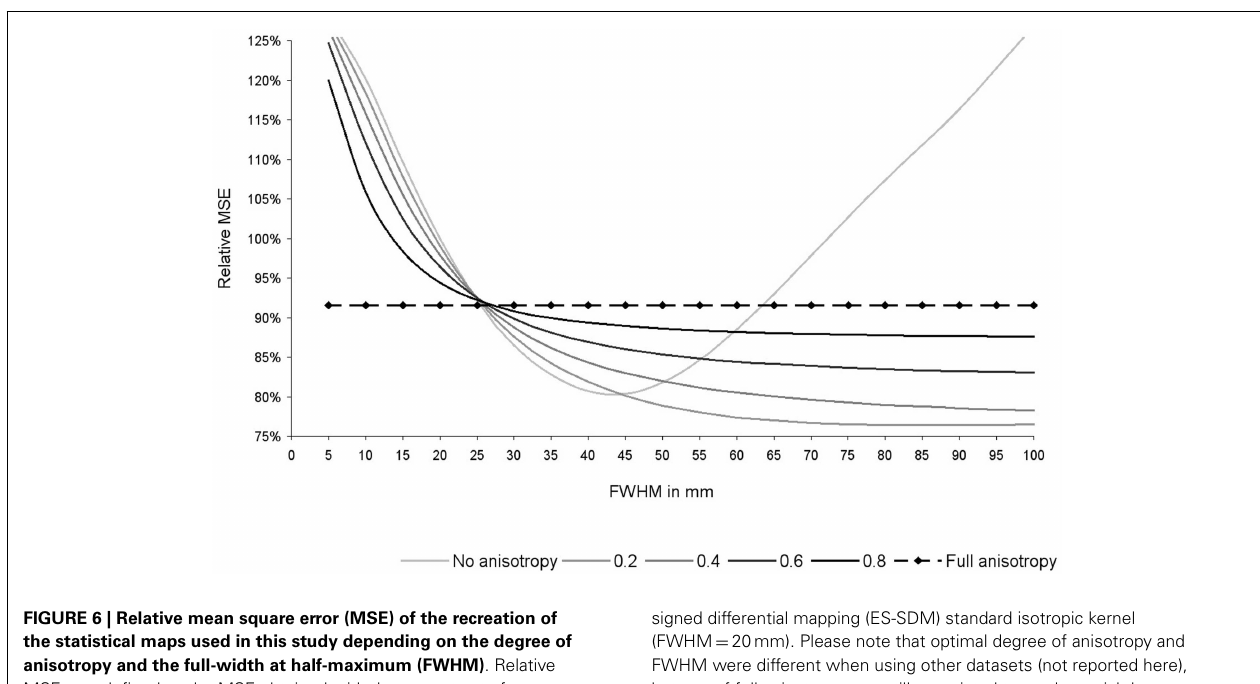
FIGURE 6 | Relative mean square error (MSE) of the recreation of the statistical maps used in this study depending on the degree of anisotropy and the full-width at half-maximum (FWHM) . Relative MSE was defined as the MSE obtained with the current set of parameters divided by the MSE obtained after applying effect-size